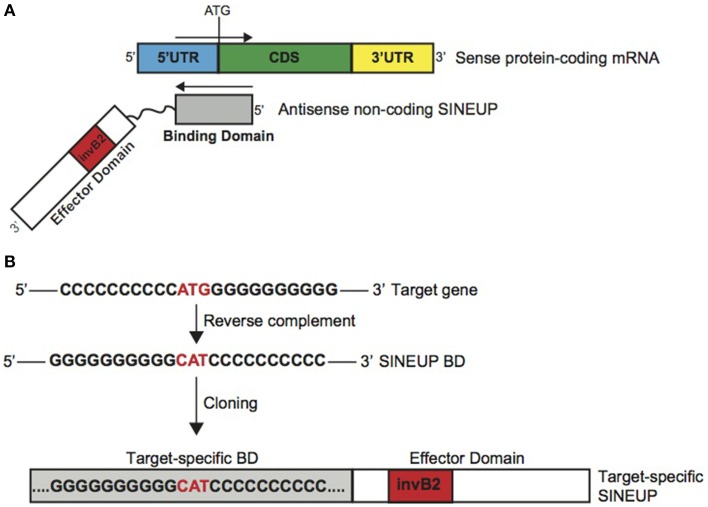
Schematic representation of SINEUPs. (A) SINEUP modular structure. SINEUP binding domain (gray): SINEUP sequence that overlaps, in antisense orientation, to the sense protein-coding mRNA. SINEUP effector domain (red): non-overlapping portion of SINEUPs (white), containing the inverted SINEB2 element (invB2) that confers activation of protein synthesis. 5′ to 3′ orientation of sense and antisense RNA molecules is indicated. Structural elements of protein-coding mRNA are shown: 5′ untranslated region (5′UTR, blue), coding sequence (CDS, green) and 3′ untranslated region (3′UTR, yellow). (B) SINEUP design strategy. Schematic representation of the cloning strategy to generate target-specific SINEUPs. An artificial target gene sequence is indicated as example. SINEUP domains are represented as in A.